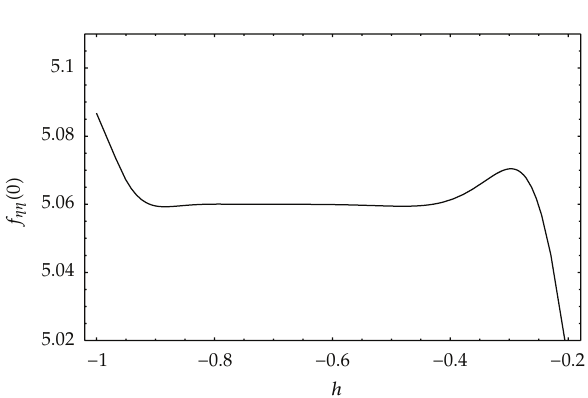
Figure 1: The h curve of f (cid:5)(cid:5) (cid:5) 0 (cid:6) at 20th order of approximation for M (cid:8) 5 and δ (cid:8) 6.